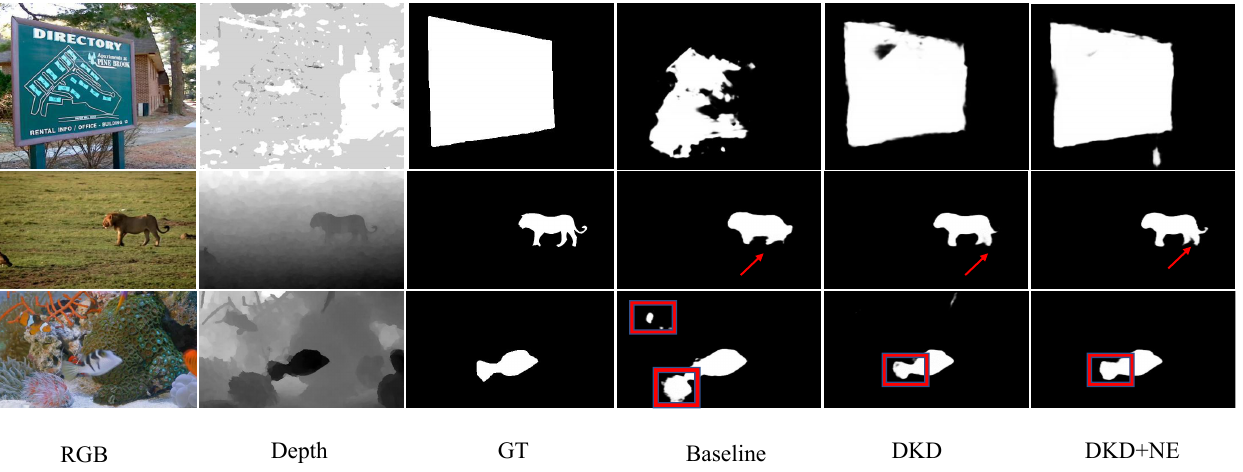
Figure 8. Heatmap visual comparisons of different distillation weights: heatmaps from left to right indicate weights 0.3, 0.5, 0.7 and dynamic, respectively.